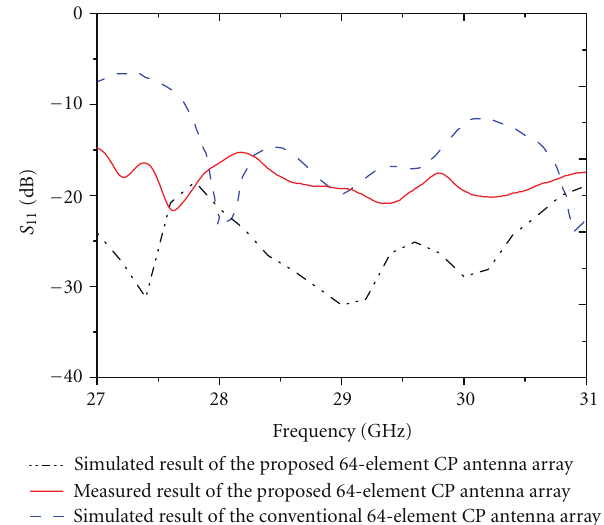
Simulated result of the proposed 64-element CP antenna array